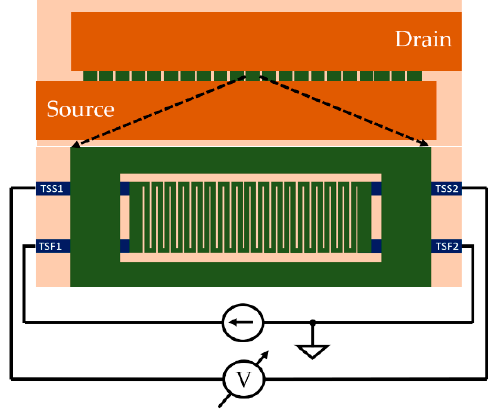
Figure 3. Temperature sensor layout representation.